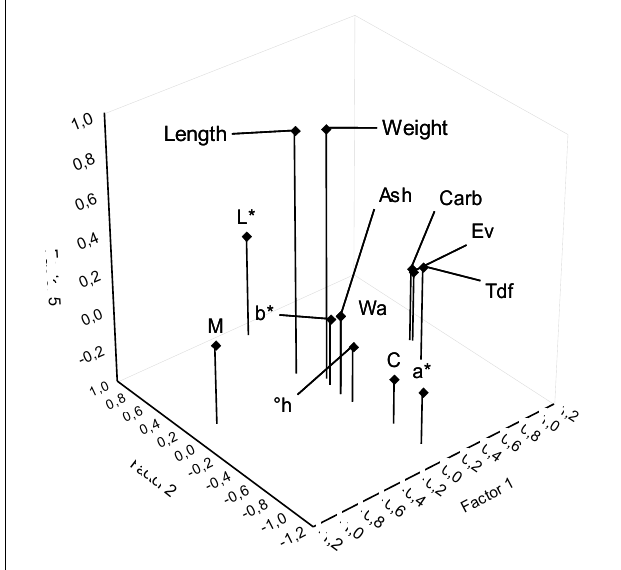
FIGURE 1 | Second exploratory factor analysis: three-dimensional distribution of independent variables as a function of Factors 1, 2, and